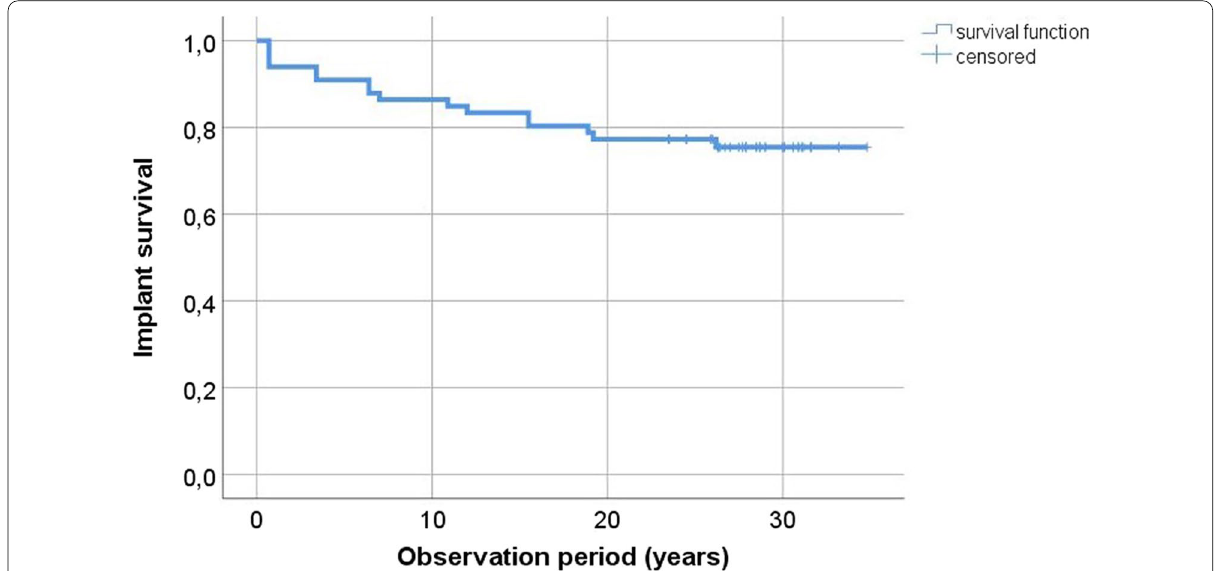
Fig. 4 Kaplan–Meier curve representing implant survival in contact group (CG)